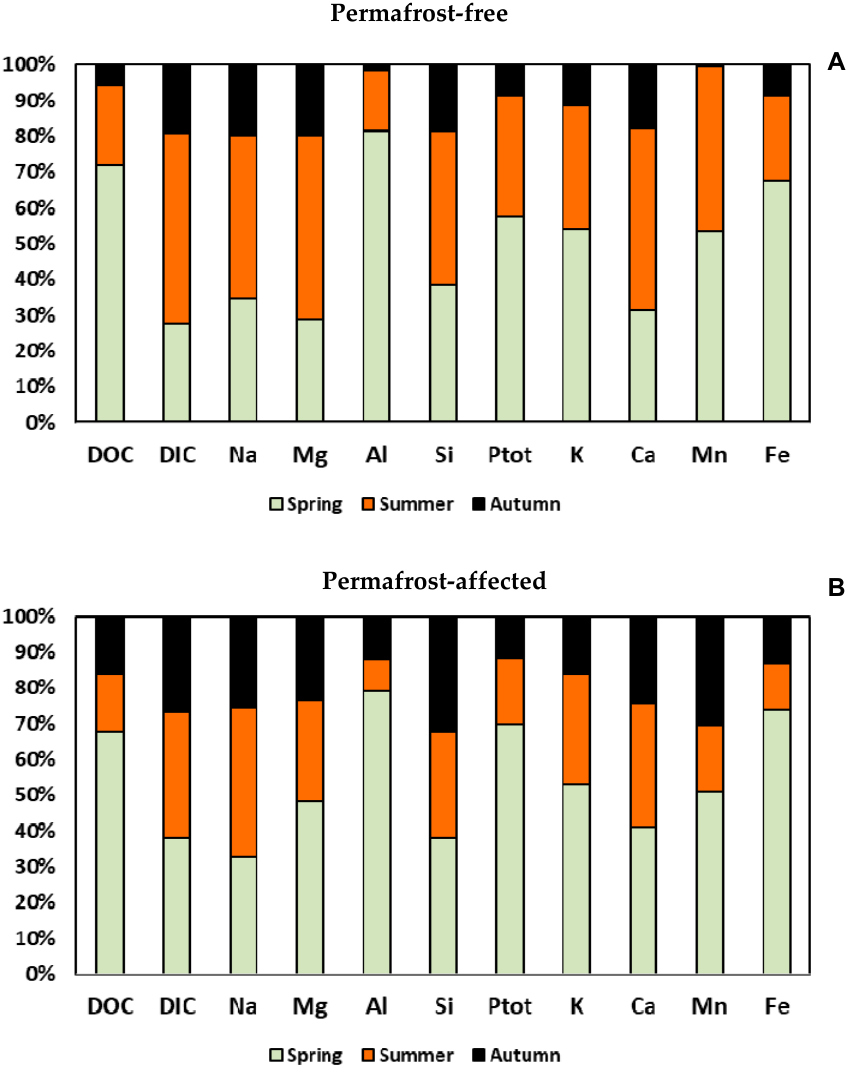
Figure 2. Partial contribution of spring, summer and autumn 2016 to overall open-water period export of elements by WSL rivers, located in the permafrost-free ( A ) and permafrost-affected ( B ) regions.